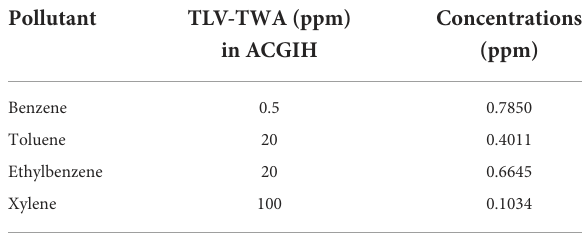
TABLE 1 Mean of BTEX (concentrations in breathing air